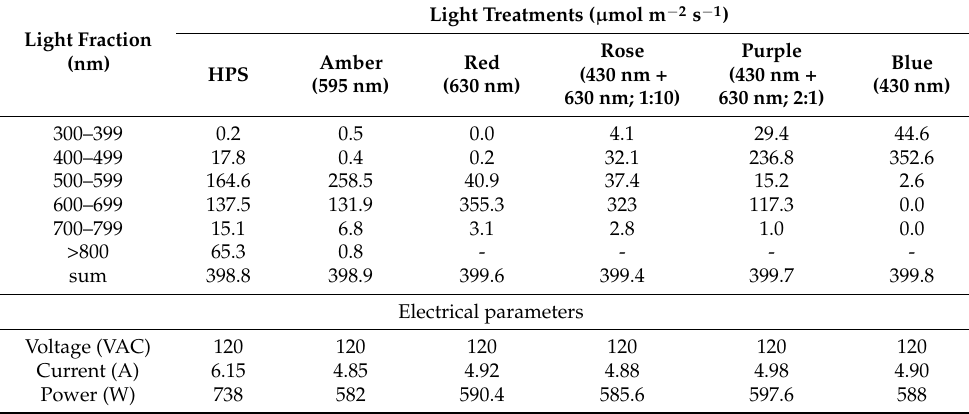
Table 5. Measured spectral and electrical parameters of light fixtures used for each light treatment. The distribution of light intensity is given in a 100 nm wide range. The Blue: red light ratios of 1:10 and 2:1 were supplied by